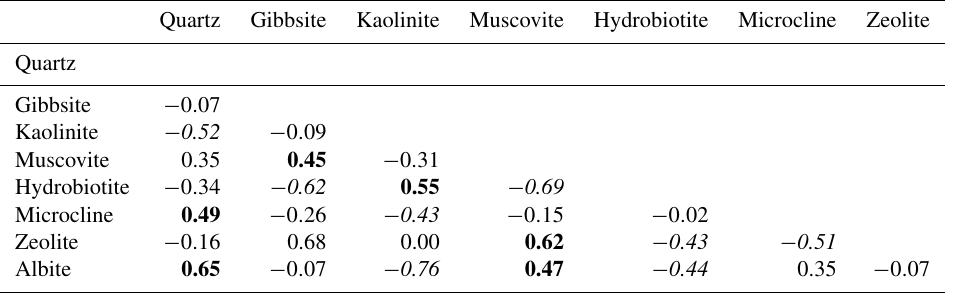
Table 1. Correlation between terrigenous-mineral phases in core M125-34-2. Positive correlations are marked by bold font (for r > 0 . 4), negative correlations (for r < 0 . 4) in italics. Quartz Gibbsite